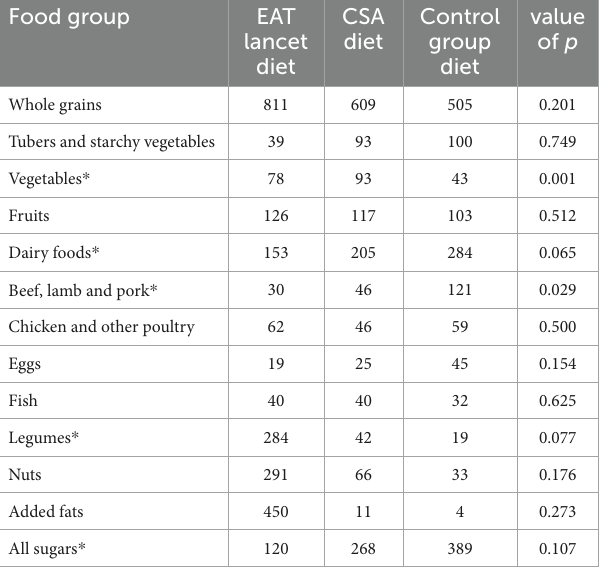
TABLE 2 Mean daily calories consumed by the control group and the CSA group according to EAT Lancet food category and comparison with dietary recommendations.